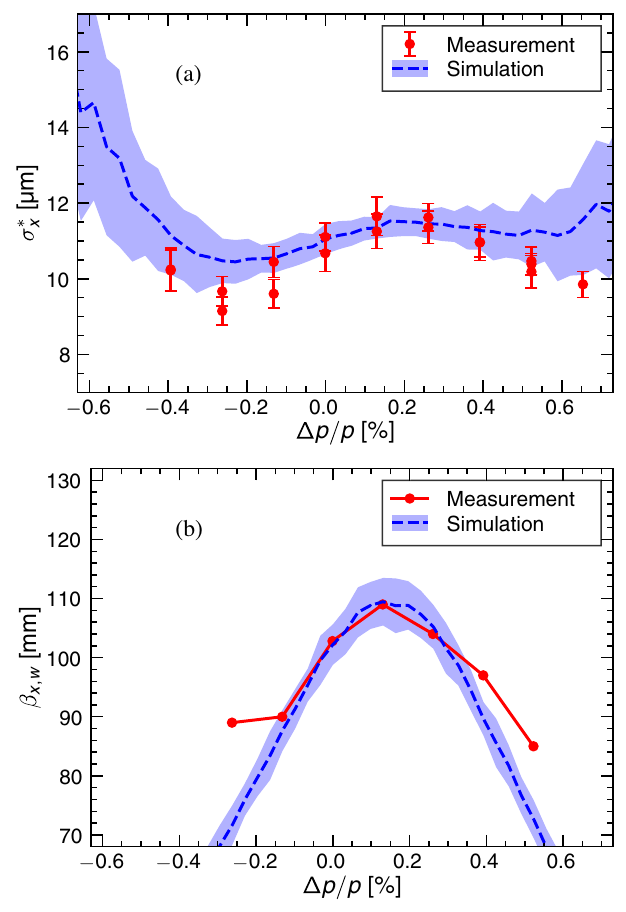
FIG. 11. Measurements of the horizontal momentum band- width (a) and chromatic horizontal β function at the waist (b) in the ultralow β (cid:1)